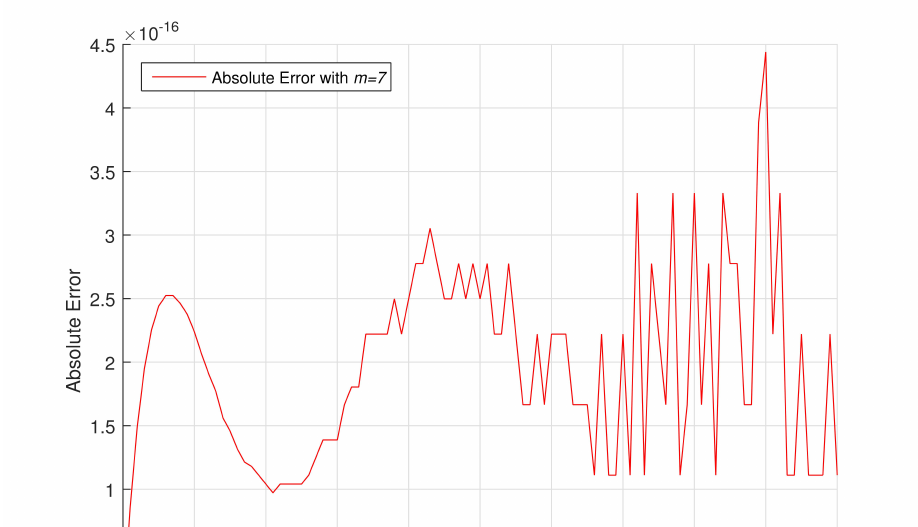
Figure 5. The absolute error with m = 4.